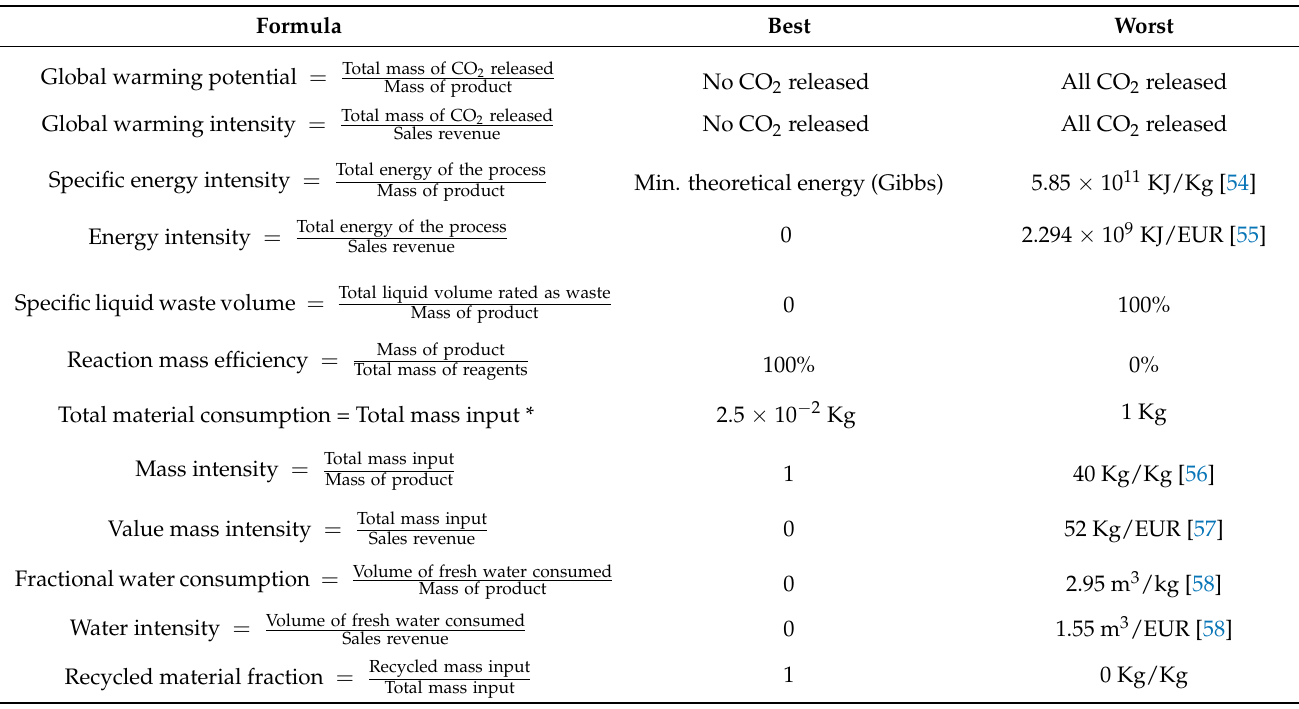
Table 2. Sustainability indicators calculation